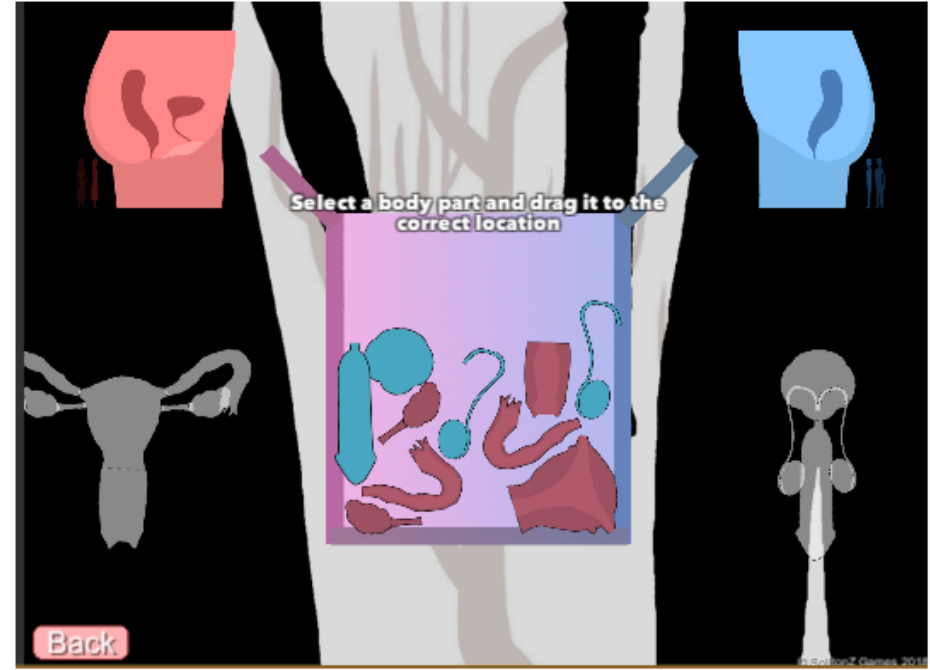
Figure 5. Screenshot of anatomy